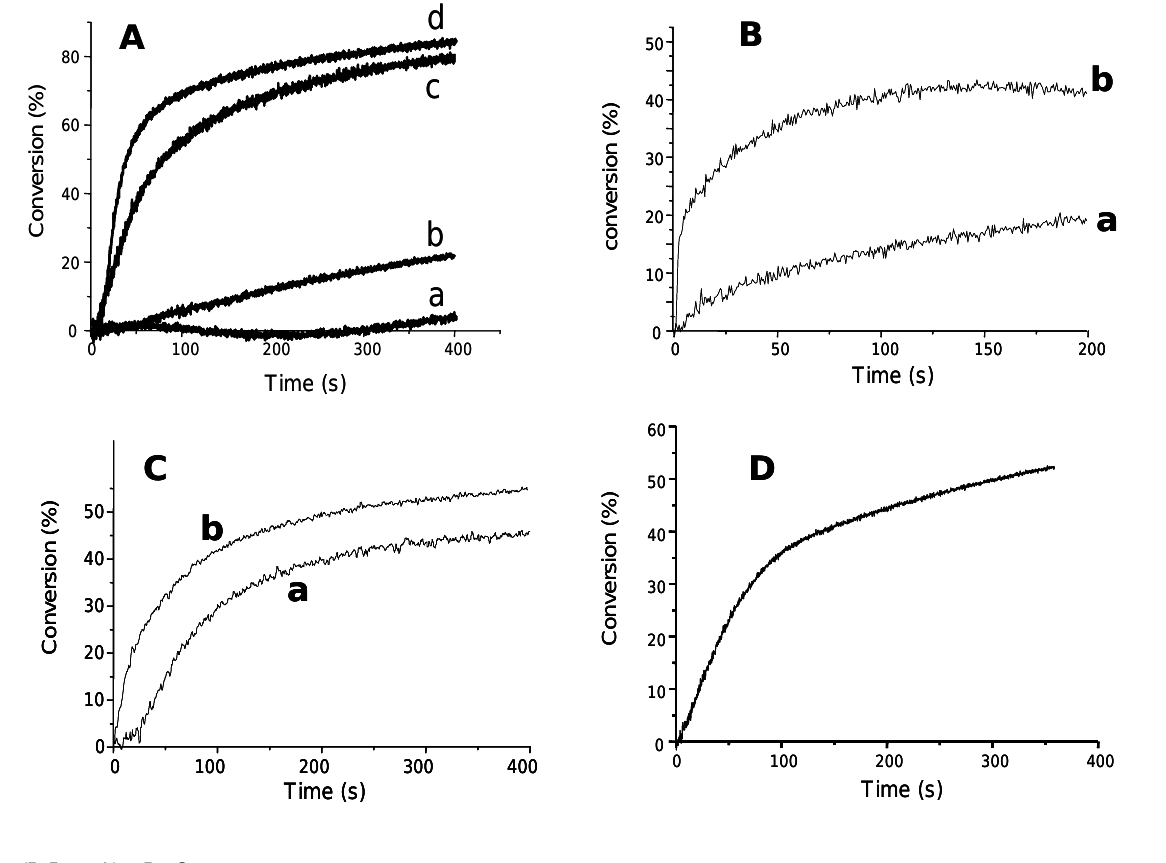
Figure 1. Photopolymerization profiles of EPOX under air. Upon Xenon lamp